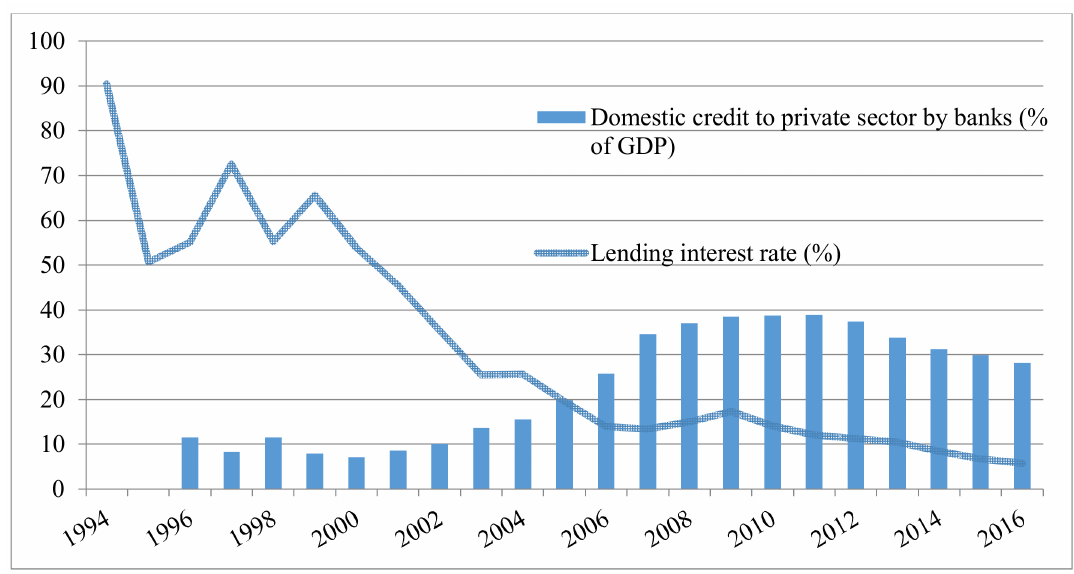
Figure 1. Financial resources provided to the private sector and interest rates evolution. Source: Authors’ own processing using World Bank data.